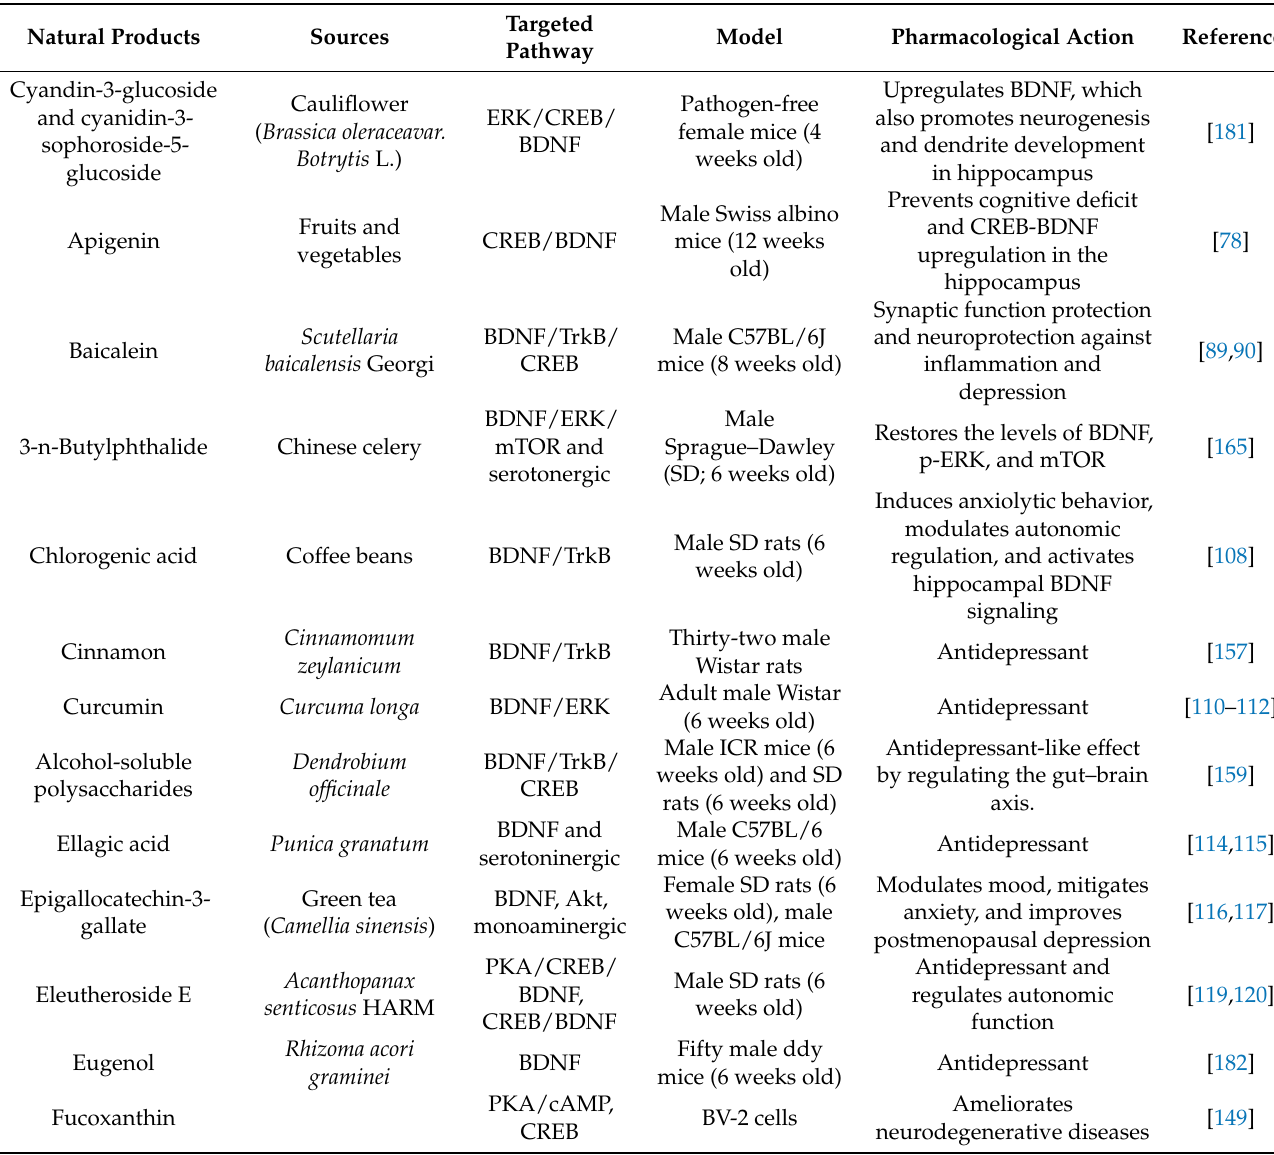
Table 1. Natural products targeting BDNF in the gut–brain axis as antidepressant